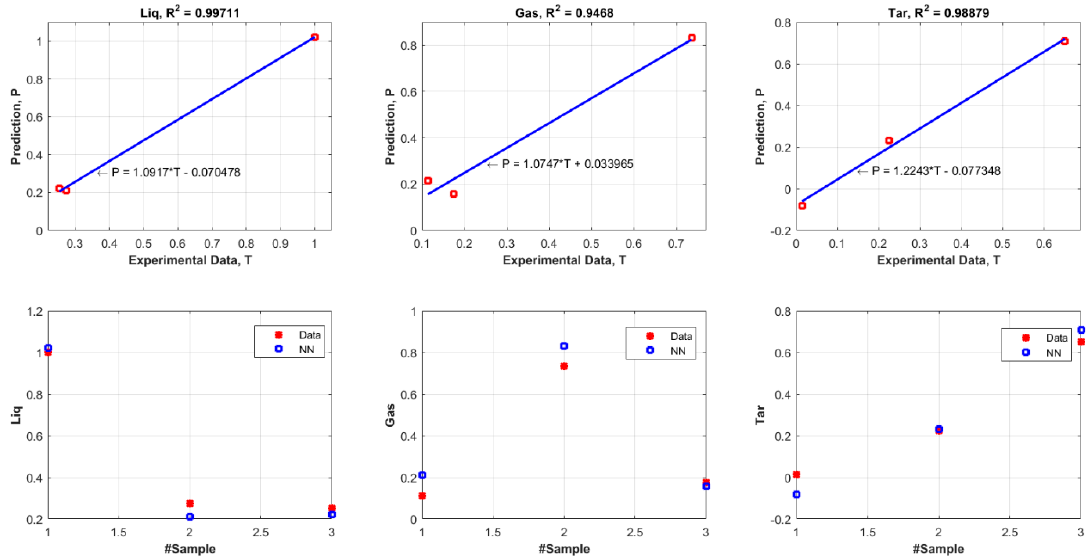
Figure 8. Comparisons between the experimental results (from validation dataset) and the predicted curve (ANN model), 𝑀𝑆𝐸 (cid:3047)(cid:3042)(cid:3047)(cid:3028)(cid:3039) (cid:3404) 0.0869 .